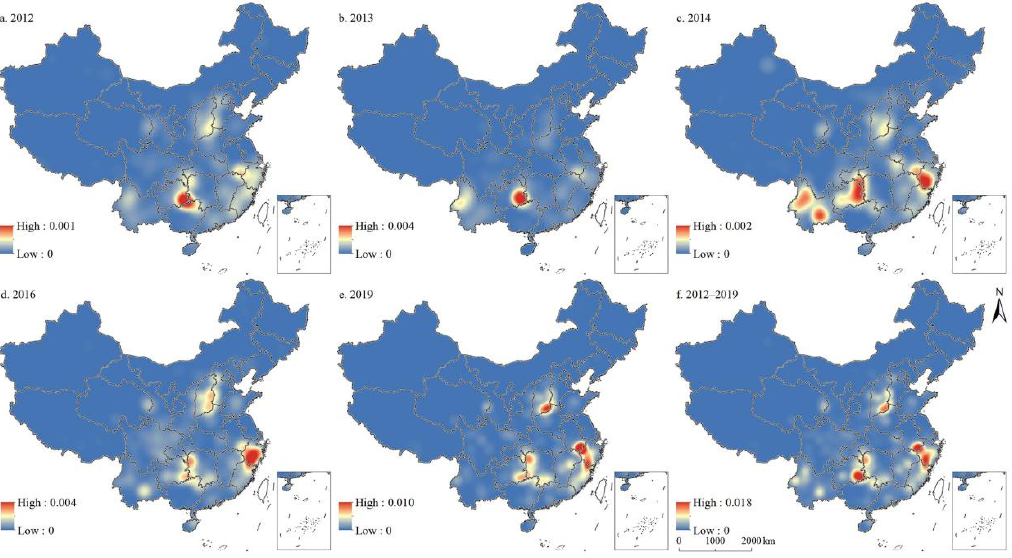
Figure 3. Distribution of kernel density of traditional villages in China.